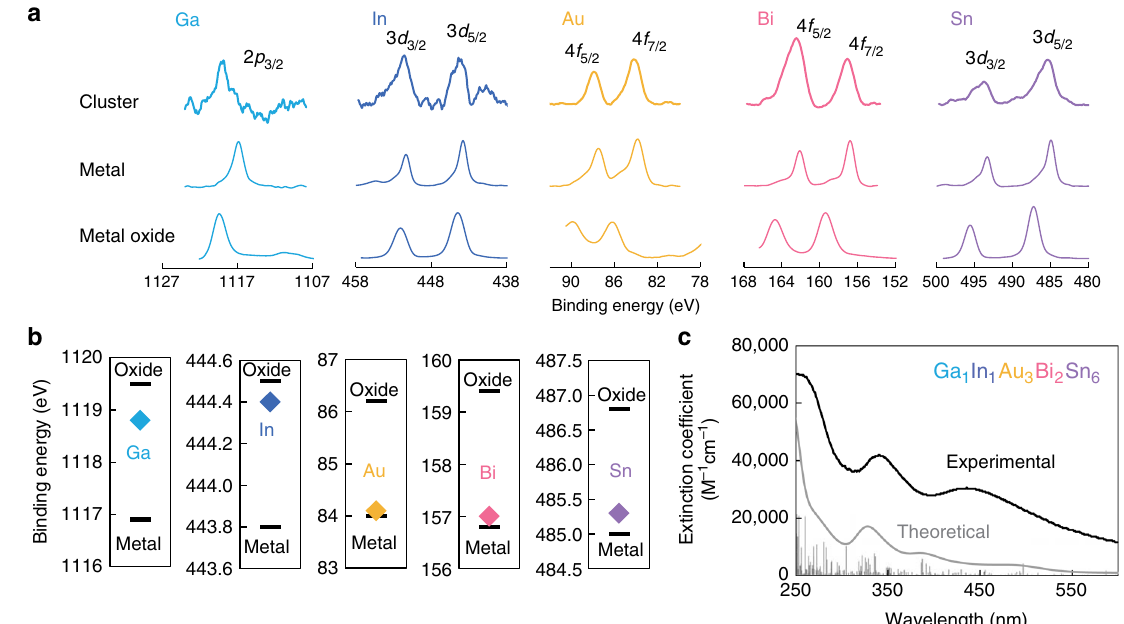
Fig. 5 XPS and UV-Vis absorption data for fi ve-element sub-nanoclusters. a XPS spectra of fi ve-element clusters on a glassy carbon substrate, metals, and metal oxides focusing on the Ga 2 p 3/2 , In 3 d , Au 4 f , Bi 4 f , and Sn 3 d core levels. b Binding energy of the fi ve-element cluster, metals, and metal oxides for each element (Ga 2 p 3/2 , In 3 d 5/2 , Au 4 f 7/2 , Bi 4 f 7/2 , and Sn 3 d 5/2 ). c UV-Vis absorption spectrum of the fi ve-element cluster with PyTPM-G4 in 1:1